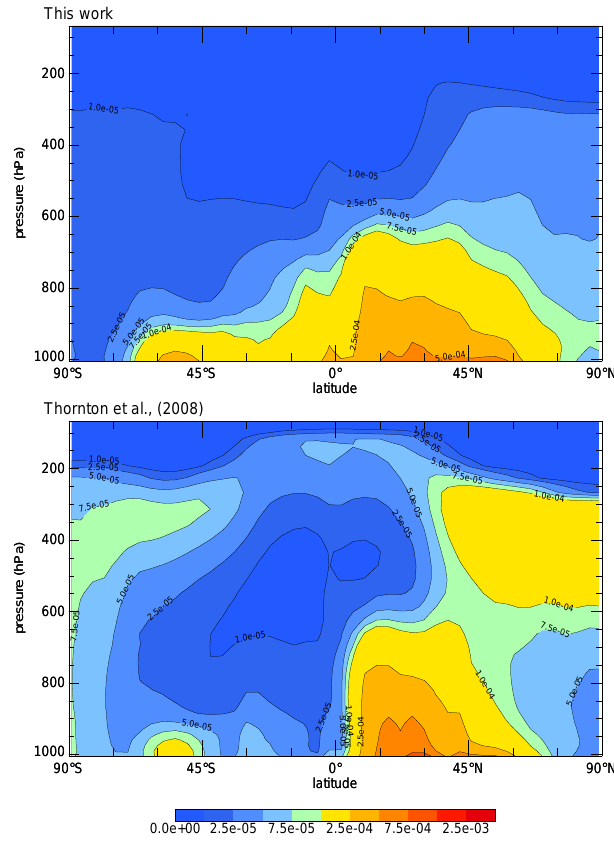
Fig. 6. Zonal annual mean heterogeneous reaction rates as calculated in the model using the parameterisation presented in this work (top panel) and the scheme of Thornton et al. (2008) (bottom).